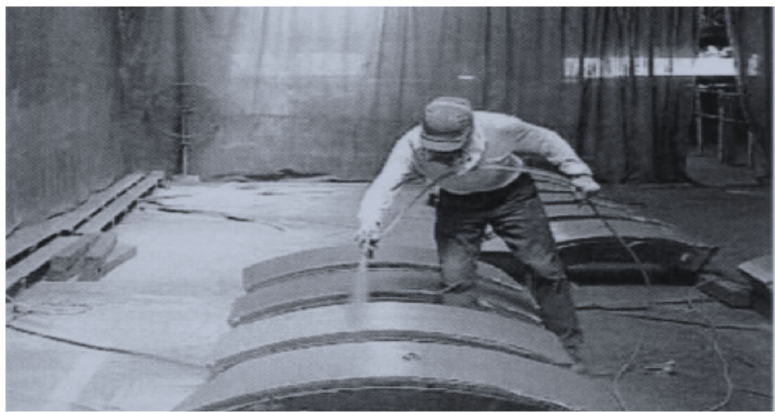
Figure 5. Grouting through tail skin.